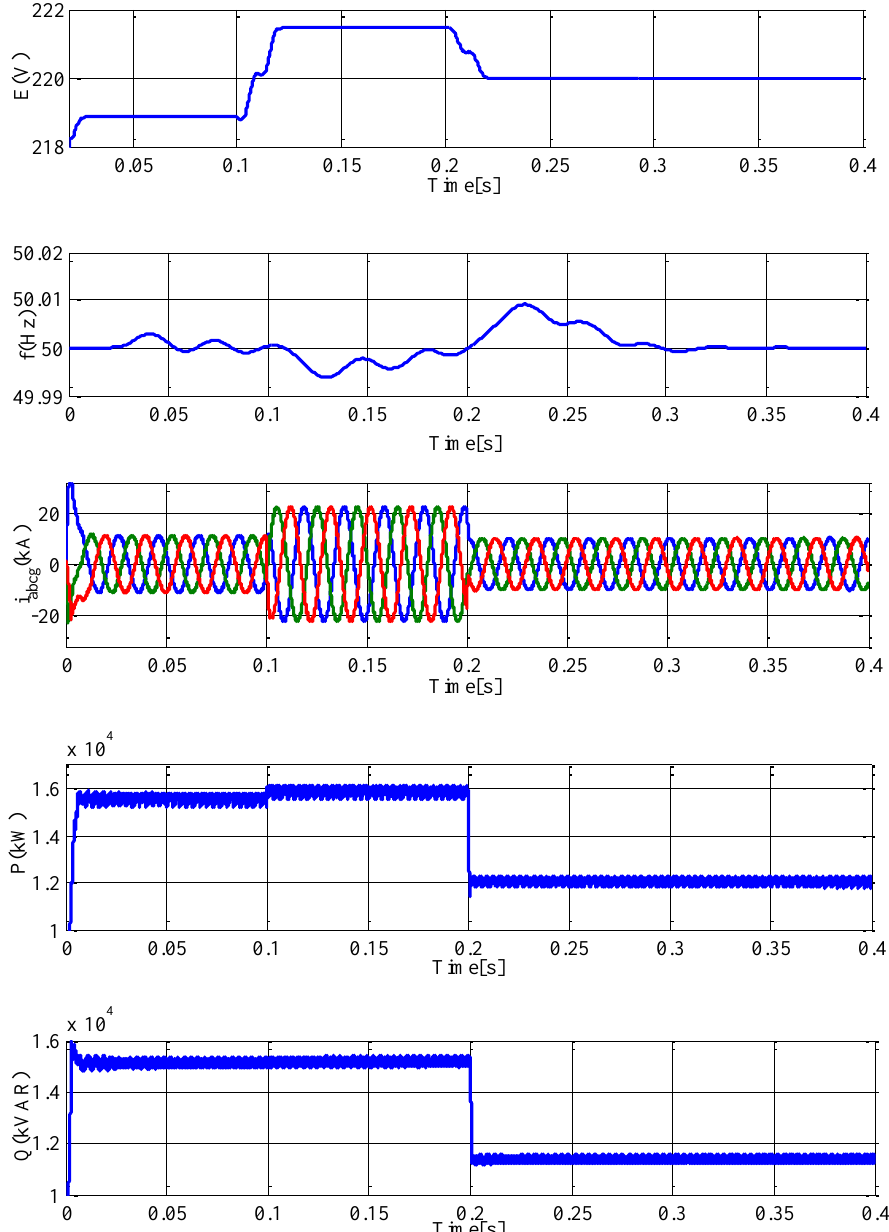
Figure 9. The grid voltage magnitude and frequency, the grid currents, and the active and reactive power of SAPIRC-based converter under a sudden connection of large-scale RERs.